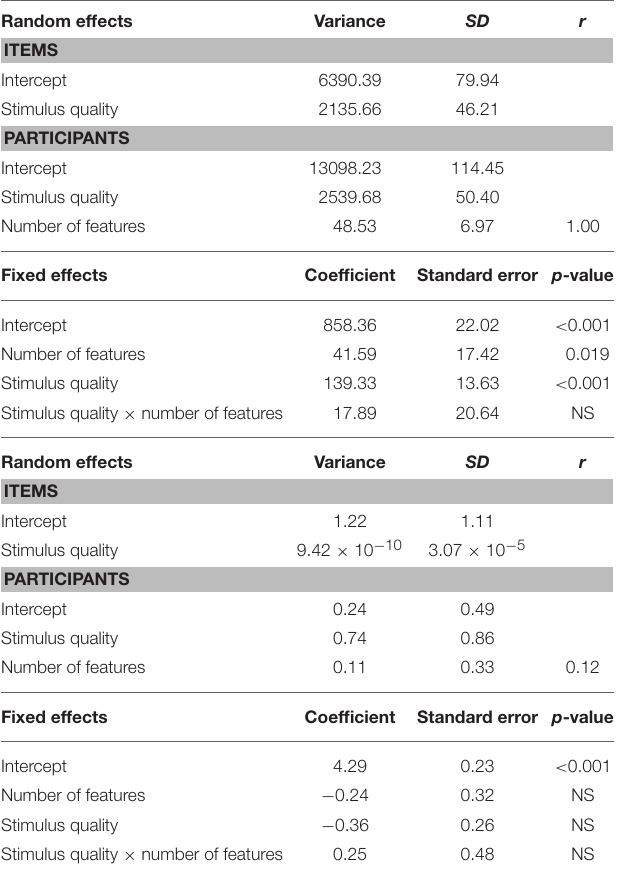
TABLE 4 | LME (top panel: RT) and GLM (bottom panel: Accuracy) model estimates for fixed and random effects for the joint effects of stimulus quality with number of